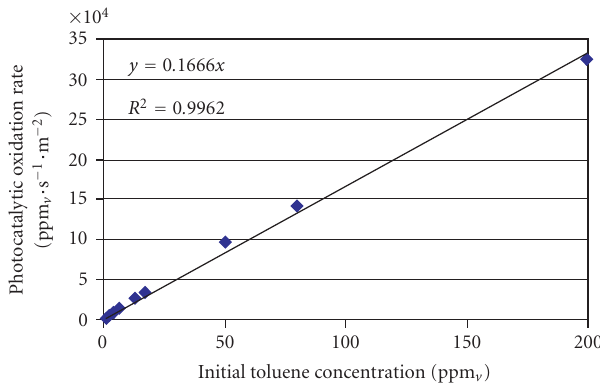
Figure 6: Variation of toluene photocatalytic oxidation rate per square meter of catalyst versus initial toluene concentration.